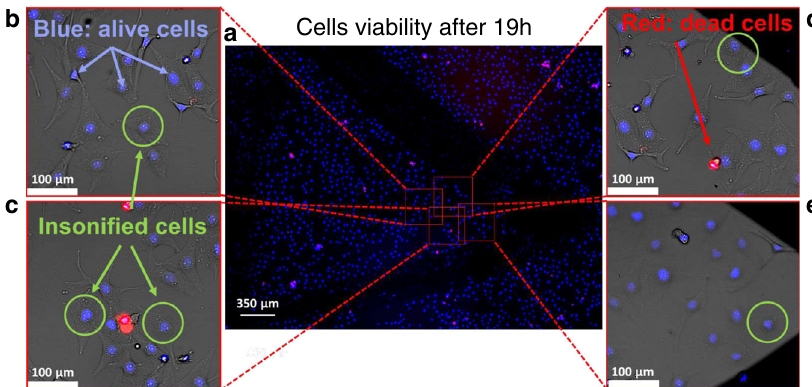
Fig. 4 Cells ’ viability monitoring. a Overview of the central part of the micro fl uidic device in which the viability experiments were performed. The cells are stained using a viability kit and imaged at 360 and 535 nm excitation (460 and 617 nm emission). The cell nucleus are represented in blue, while the dead cells appear in red. The whole fi eld of view contains 4581 cells (226 dead — 5%) while the region where manipulation took place contains 166 cells (5 dead — 3%). b – e Details of the fi ve cells exposed to the acoustical tweezers for 2 min (four others were exposed on another similar device). The green circle represents the fi rst ring of the trap. Long-term viability tests were performed overall on nine insoni fi ed cells in two different micro fl uidic